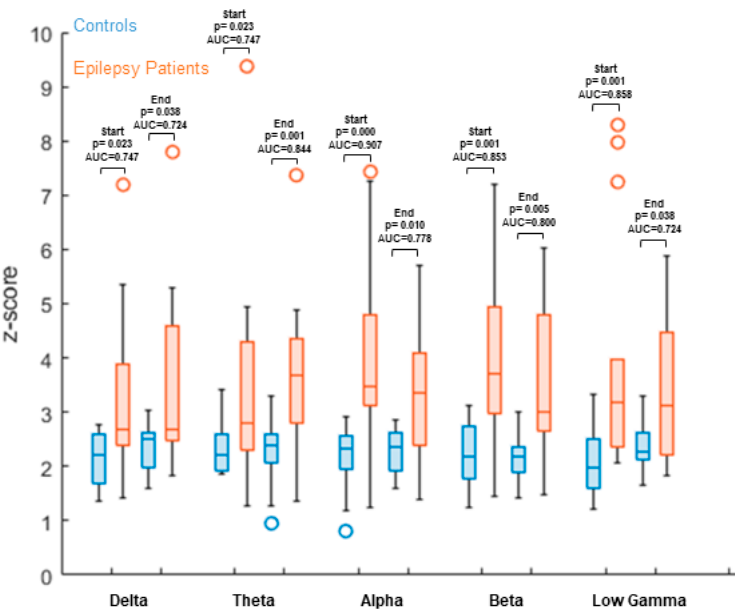
Figure 1. Max. node degree comparison between 15 healthy controls and 15 patients with focal epilepsy, comparing: (1) controls recording before an exhausting task with patient data; and (2) after an exhausting task with patient data. Results showed significantly increased values, as seen in graph data. Z-values are calculated based on the mean and standard deviations of the control group for each parcel. The mean value over all parcels is then calculated and used as the result of the individual subject. These results are then displayed separately per group. Z-values between groups are compared using a non-parametric Wilcoxon rank-sum test, as well as ROC AUC.